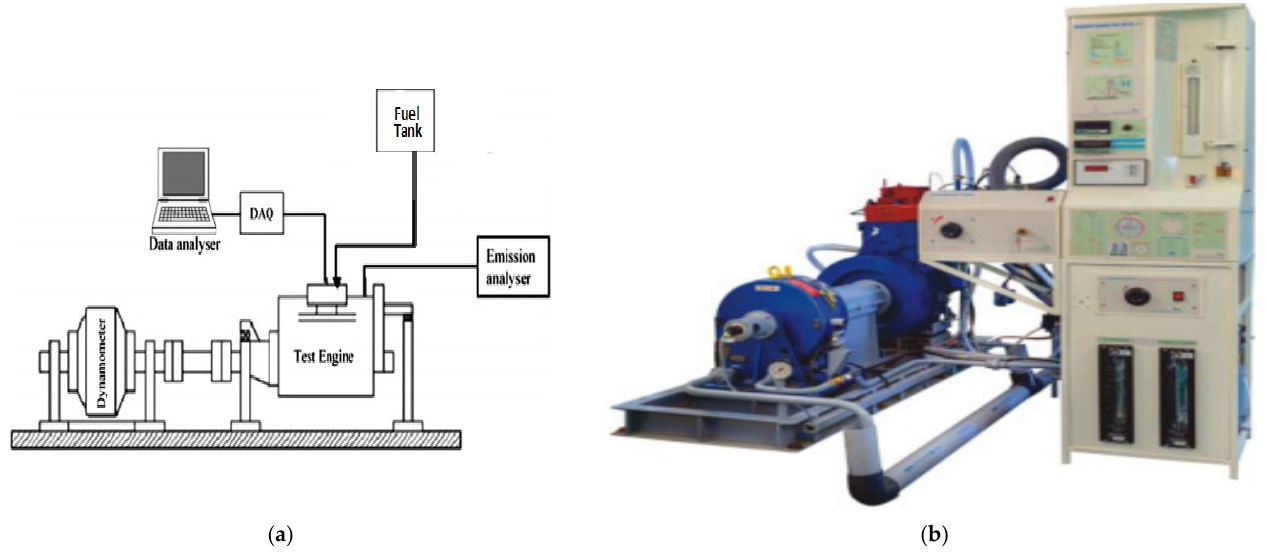
Figure 1. ( a ) Layout of experimental setup; ( b ) Photographic view of experimental setup.